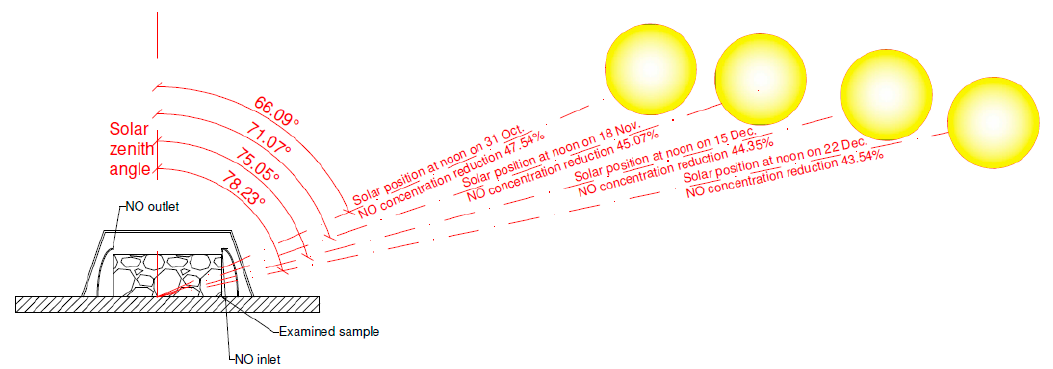
Figure 12. Results of NO x abatement with the solar zenith angle characteristic to specific dates of the solar position at noon.